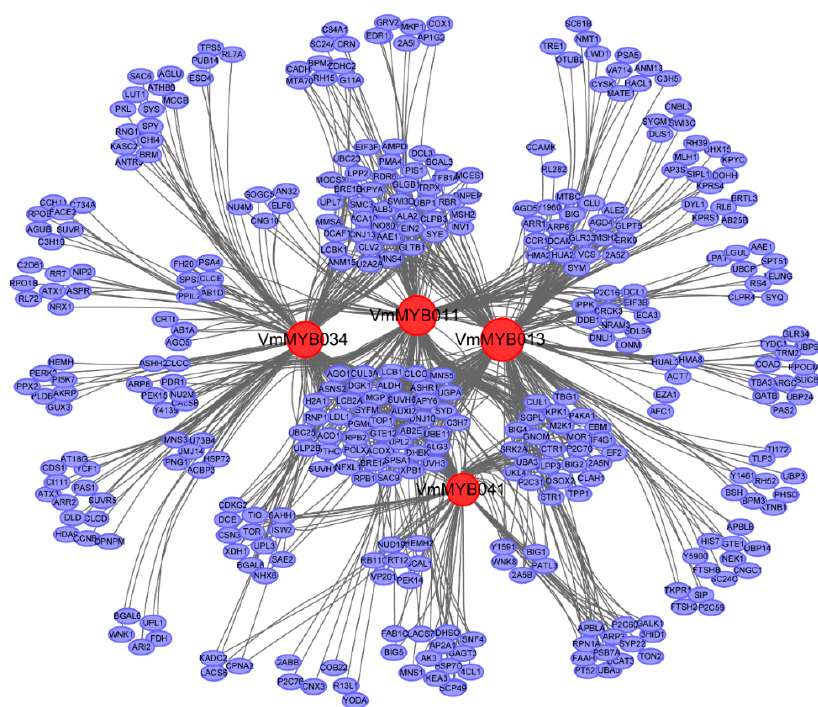
Figure 5. Network analysis of VmMYB013, VmMYB034, VmMYB011 and VmMYB041 hub genes in response to Fof-1 . The four hub genes interacted with 634 genes and exhibited a total of 1157 interactions. The red nodes represent the four hub genes. Bottle blue nodes represent the interaction genes.